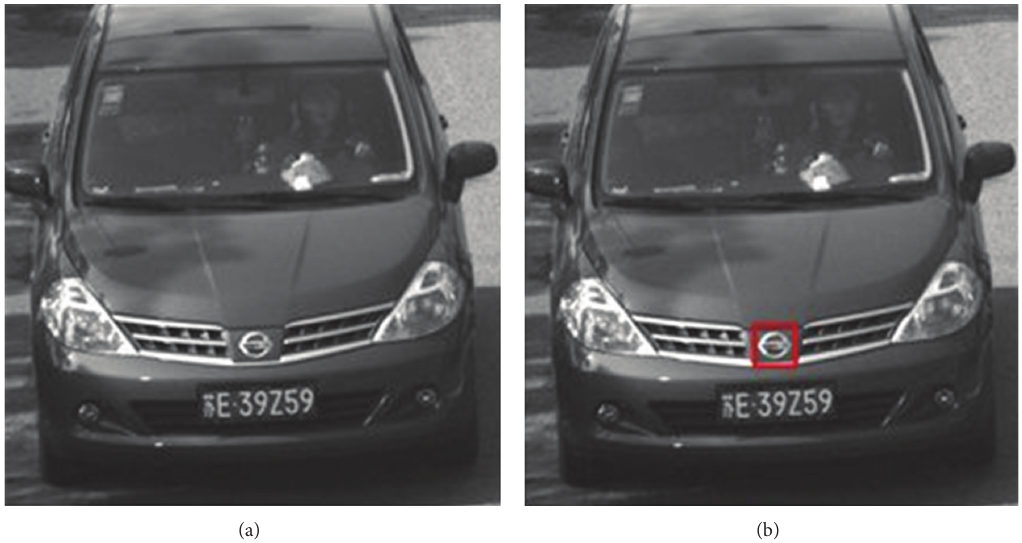
Figure 19: The left-side image is the result of Gentle Adaboost and the right-side is the result from SVM.